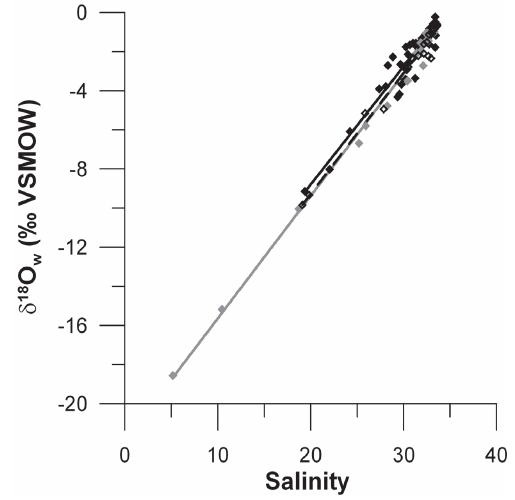
Fig. 5. Scatter plot showing the relationship between δ 18 O w val- ues and salinity for the three sampling locations: δ 18 O w = 0 . 631 · S − 21 . 84 (R 2 = 0 . 9778; p< 0 . 0005; n = 202). Black diamonds and solid line are GF3; open diamonds and black dashed line are GF5; grey diamonds and solid line are